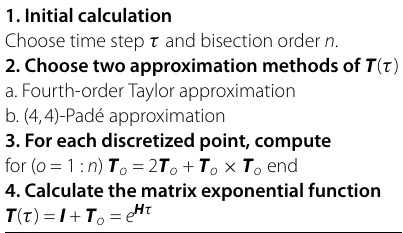
Table 1 Algorithm: How to calculate exponential matrix with PIM 1. Initial calculation Choose time step τ and bisection order n